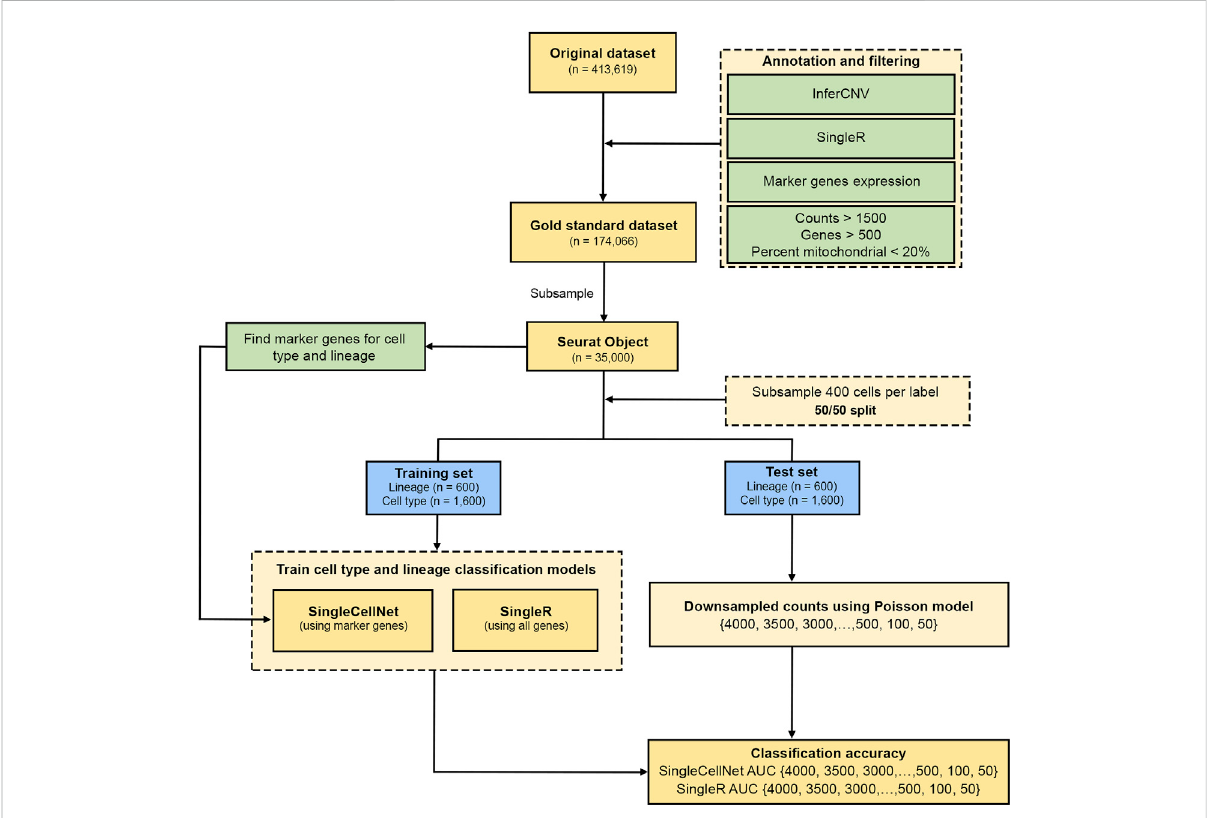
FIGURE 1 Analysis plan work fl ow. Flow chart shows the process of initial QC and generation of gold standard cell type annotations from the FELINE dataset. This is followed by a 50/50 split of a subsample into training and test sets for both SingleR and SingleCellNet classi fi ers for all datasets. The test set counts were then transformed using a Poisson model using different thresholds which is then used to determine the classi fi cation accuracy of lineage and cell type